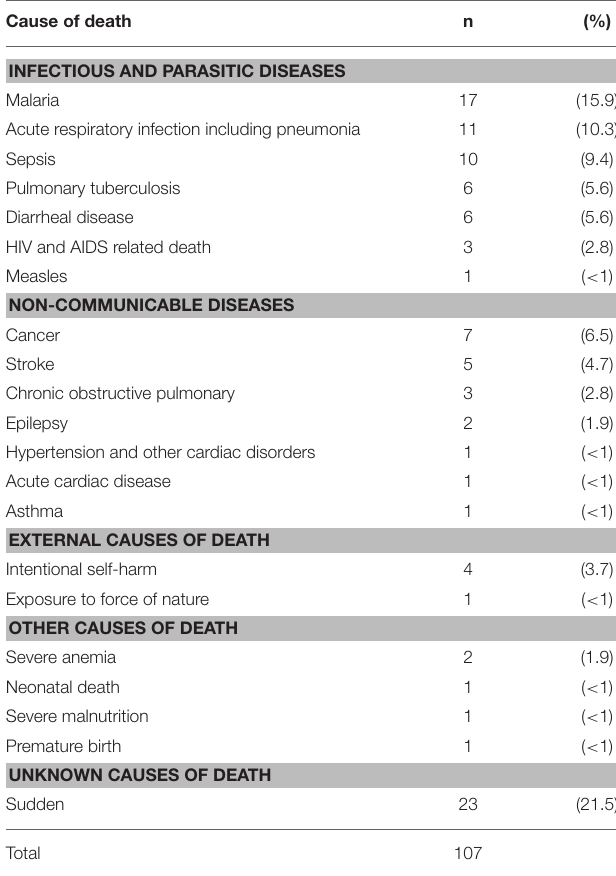
TABLE 3 | Causes of death documented by health surveillance assistants/medical doctor using the WHO verbal autopsy tool in 17 villages, Traditional Authority, Mtema, Malawi: April 2016–September